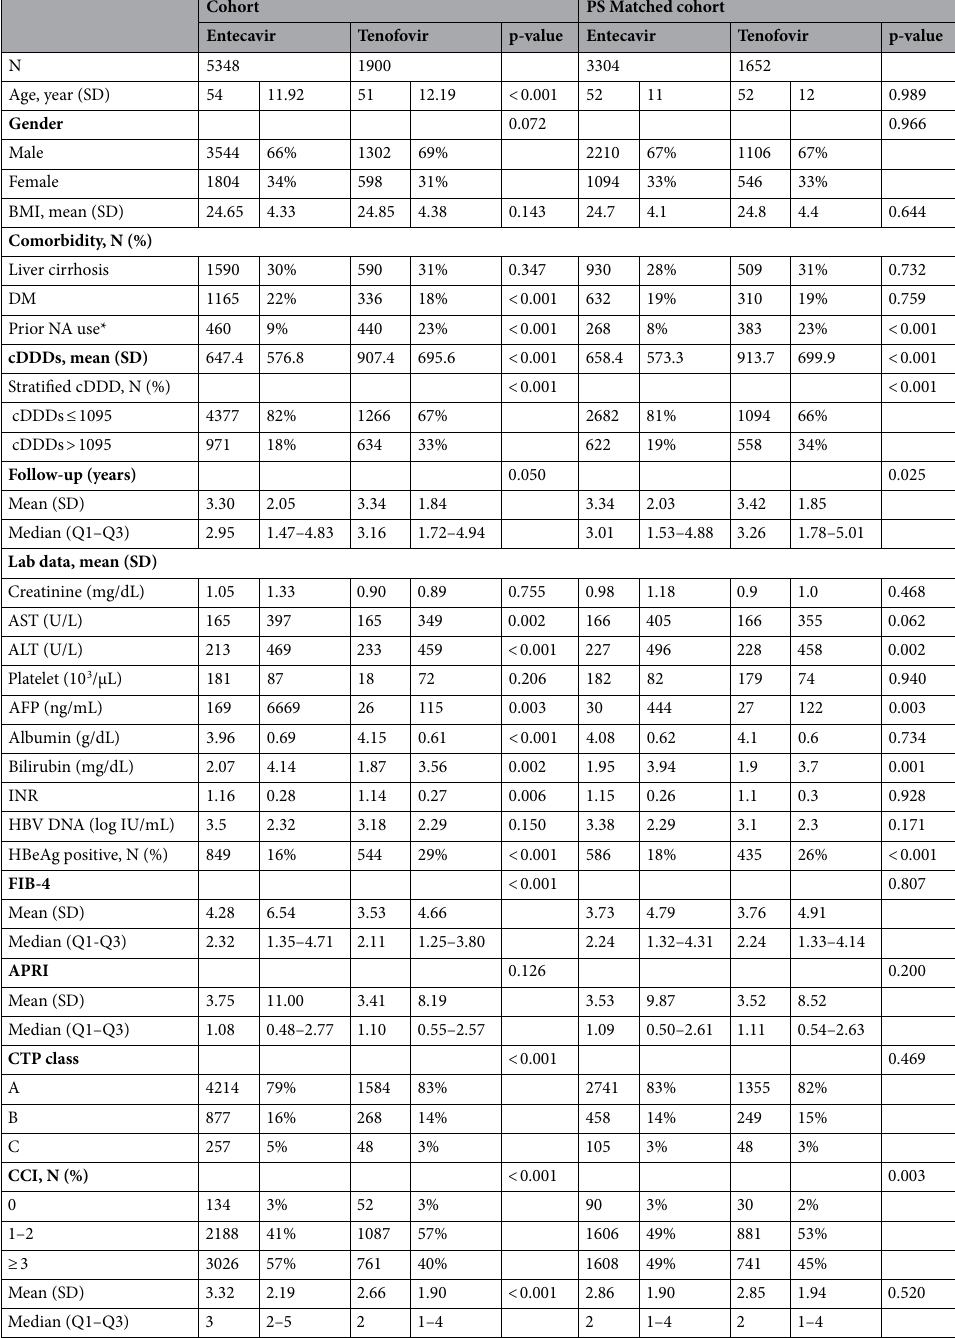
Table 1. Baseline characteristics. PS propensity score, SD standard deviation, BMI body mass index, DM diabetes mellitus, NA nucleos(t)ide analogue, cDDD cumulative defined daily doses (DDDs), AST aspartate aminotransferase, ALT alanine aminotransferase, AFP alpha-fetoprotein, INR international normalized ratio, HBV hepatitis B virus, HBeAg hepatitis B e antigen, FIB-4 fibrosis index based on 4 factors, APRI AST to platelet ratio index, CTP Child–Turcotte–Pugh, CCI Charlson comorbidity index. *Lamivudine, telbivudine,